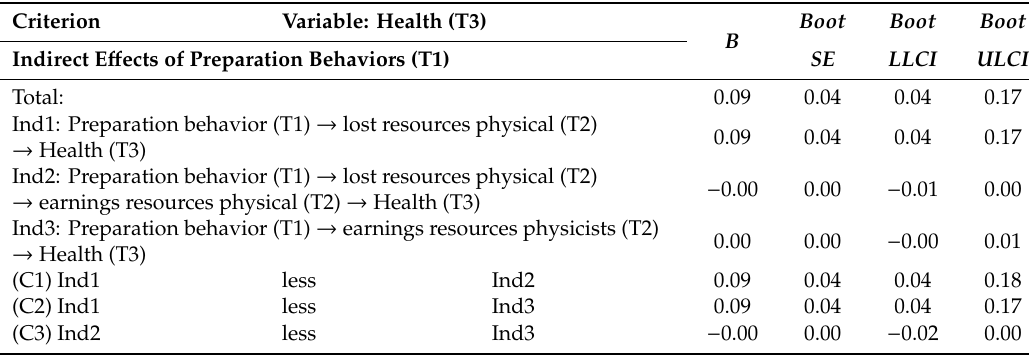
Table 8. Comparison of the indirect effects of preparation behaviors (T1) through physical resource losses (T2) and gains (T2) in the prediction of health (T3).